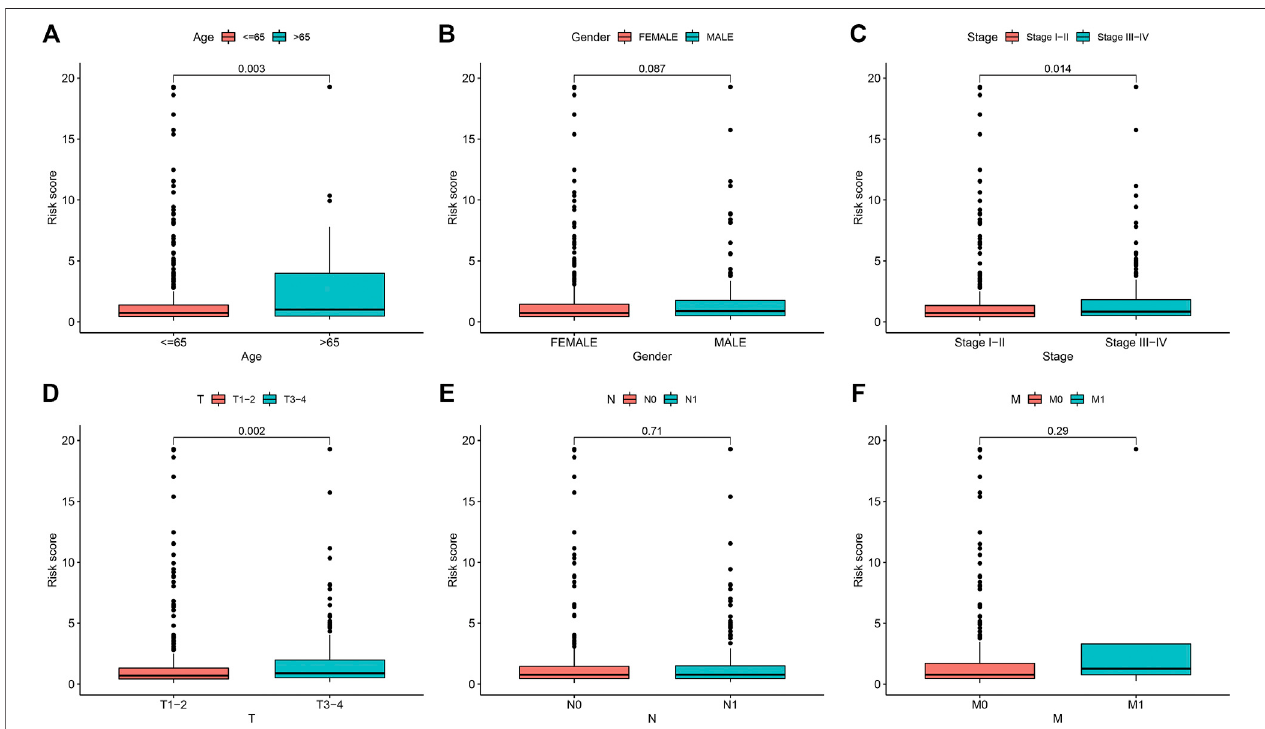
FIGURE 7 | Correlation between RS and clinical characteristics in THCA. (A) age > 65 years old and < 65 years old (B) female and male (C) Stage I-II and stage III − IV, (D) T stage (E) Nstage (F) Mstage. Age over 65 years old, higher pathological stage, and higher T stage correlated with higher RS, with p (cid:1) 0.003, p (cid:1) 0.014, and p (cid:1) 0.002, respectively. RS, risk score; THCA, thyroid